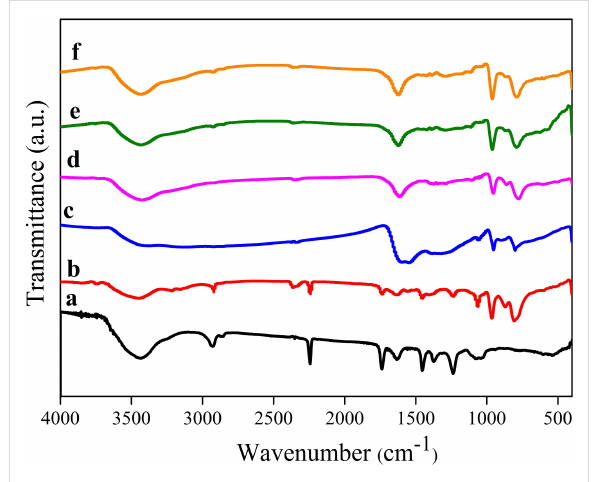
Figure 2: FTIR spectra of (a) PAN fibers and MoO 2 –CNFs (b) as-pre- pared PAN/PMA composite fibers, and (c–f) fibers calcined at 550 °C, 650 °C, 750 °C and 850 °C,